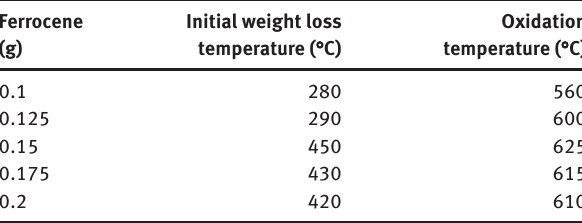
Table 2: Data extracted from TGA